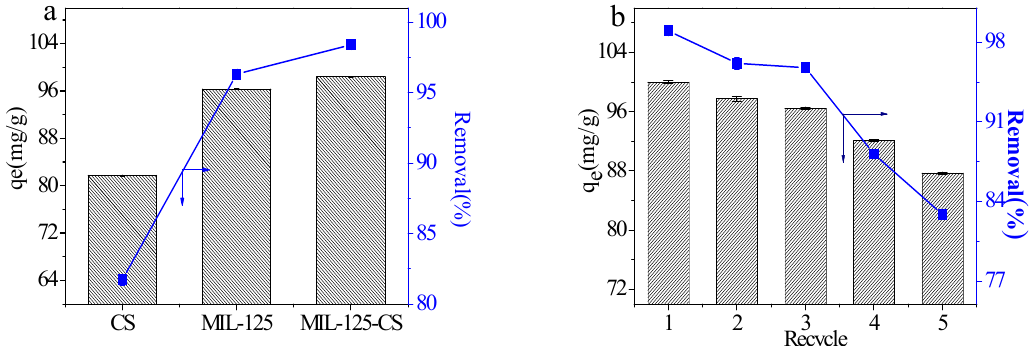
Figure 9. Adsorption capacities and removal ratios (%) of CS, MIL-125 and the MIL-125-CS beads ( a ) and the reusability of the MIL-125-CS beads for Pb(II) adsorption ( b ).